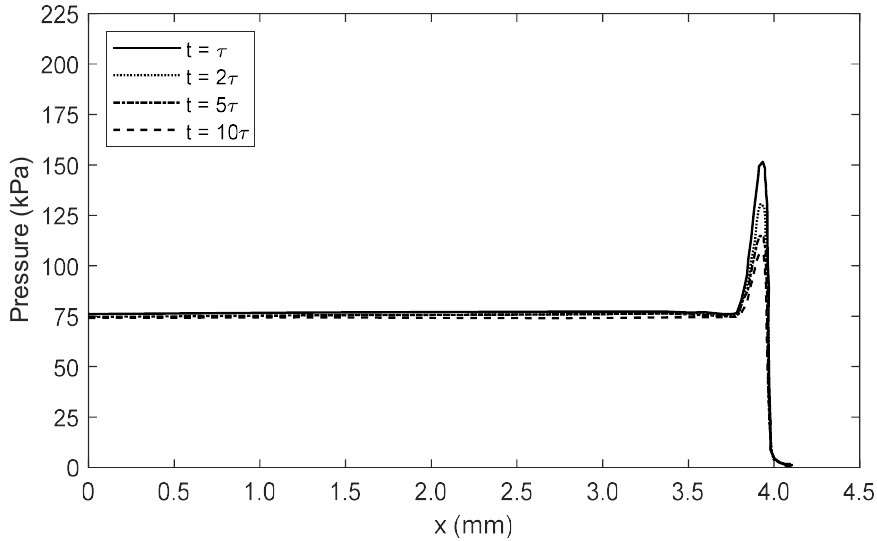
Figure 4. Measured axisymmetric contact pressure distribution (normal load of 3.9